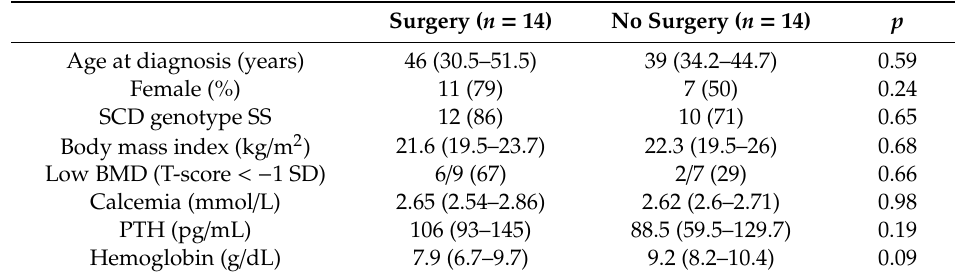
Table 5. Comparison of SCD patients with primary hyperparathyroidism at the time of pHTP diagnosis according to their surgical